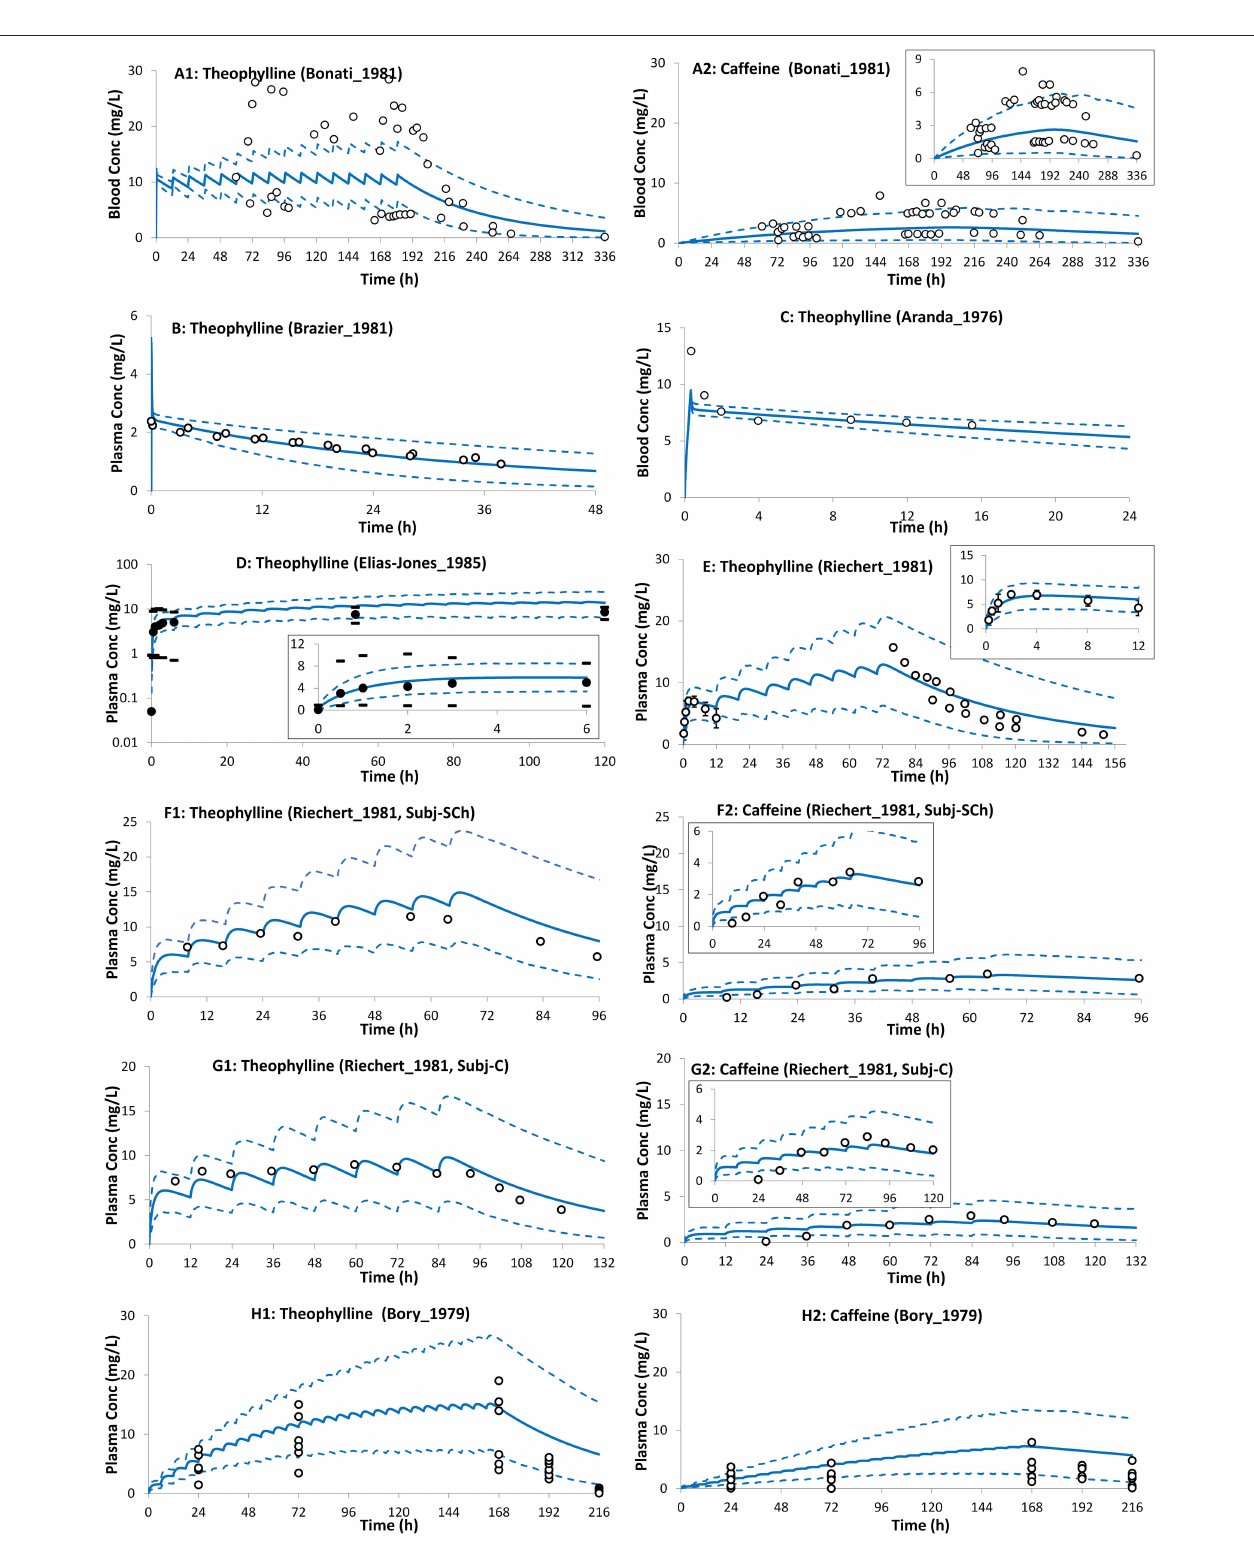
FIGURE 5 | Theophylline (and formed caffeine) concentration profiles in neonates after intravenous (A–C) and oral (D–H) administration of theophylline. Solid lines, predicted means; Dashed lines, 5th and 95th centiles; closed circles, individual observations; closed circles (D,E) , mean; dashes associated with observations in (D) represent reported ranges, and bars [ (E) ; till 12h] represent SD. (A1,A2) Trial design N1 (28), (B) Trial design N2 (48), (C) Trial design N3 (57), (D) Trial design N4 (55), (E) Trial design N5 (58), (F1,F2) Trial design N6 (58) subject-Sch, (G1,G2) Trial design N6 (58) subject-C, and (H1,H2) Trial design N7 (27). See the Method section for trial